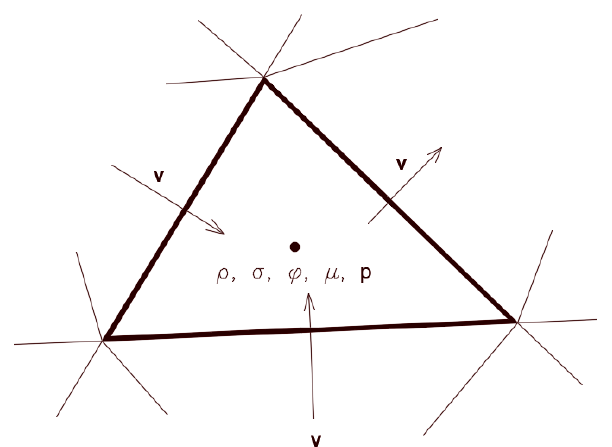
Figure 10. Schematic of a typical finite volume element over which the governing equations were discretized. In the finite volume method, variables are defined at either cell centers or cell faces. Usually, the velocity and stress tensors are defined at the faces, while fluid properties, pressure, and the phase-field function are defined at cell centers.